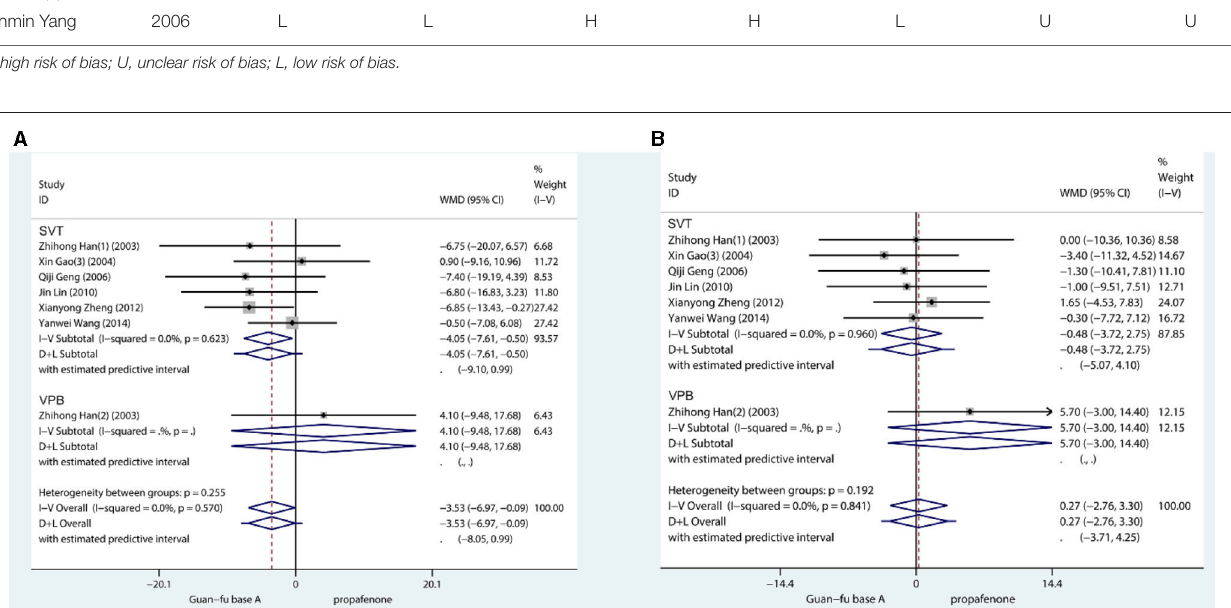
better than propafenone for resuscitation (WMD = − 1.18, 95% CI: − 2.30, − 0.07, P = 0.04, I 2 = 0.0, P = 0.79) ( Figure 5